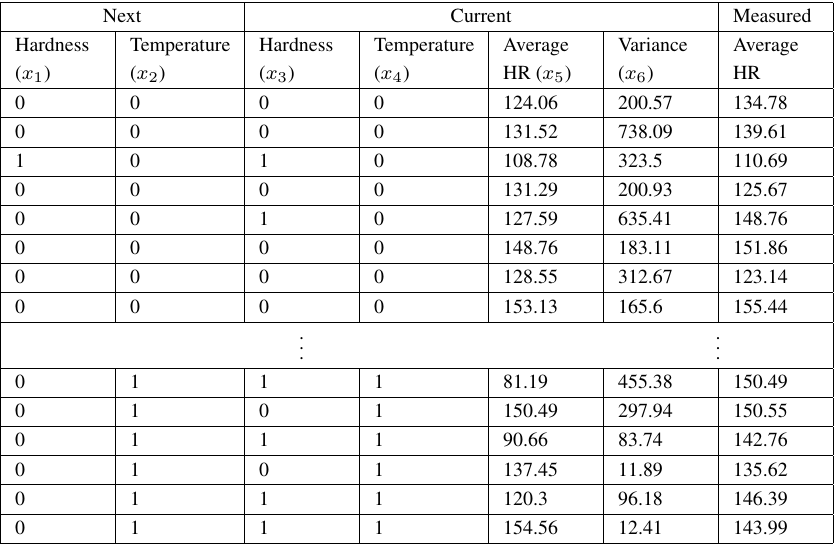
Table 2. Knowledge base data-set